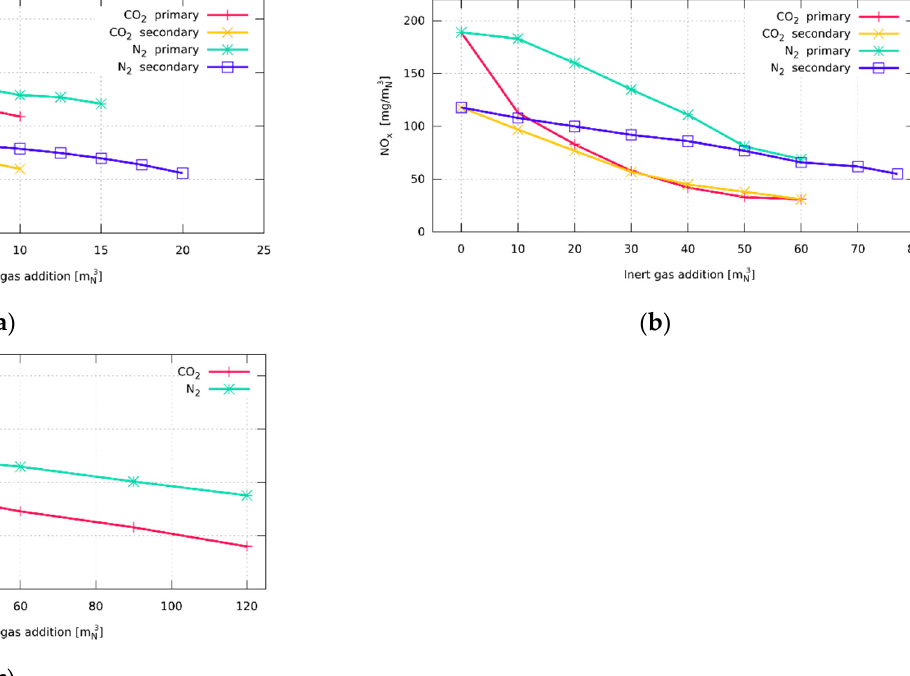
Figure 6. Influence of inert gas addition on total NO x emissions: ( a ) burner with staged fuel distri-